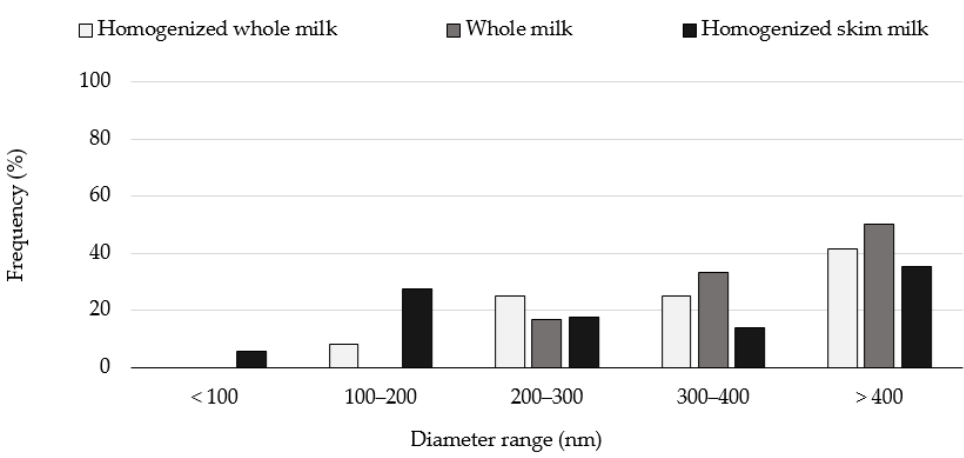
Figure 6. Casein micelle diameter distribution in untreated whole and skimmed milk samples. The measurements were recorded from the micrographs using the scanning electron microscopy equip- ment